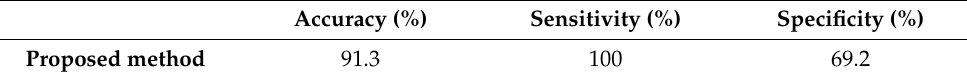
Table 2. Processing result of the grading.